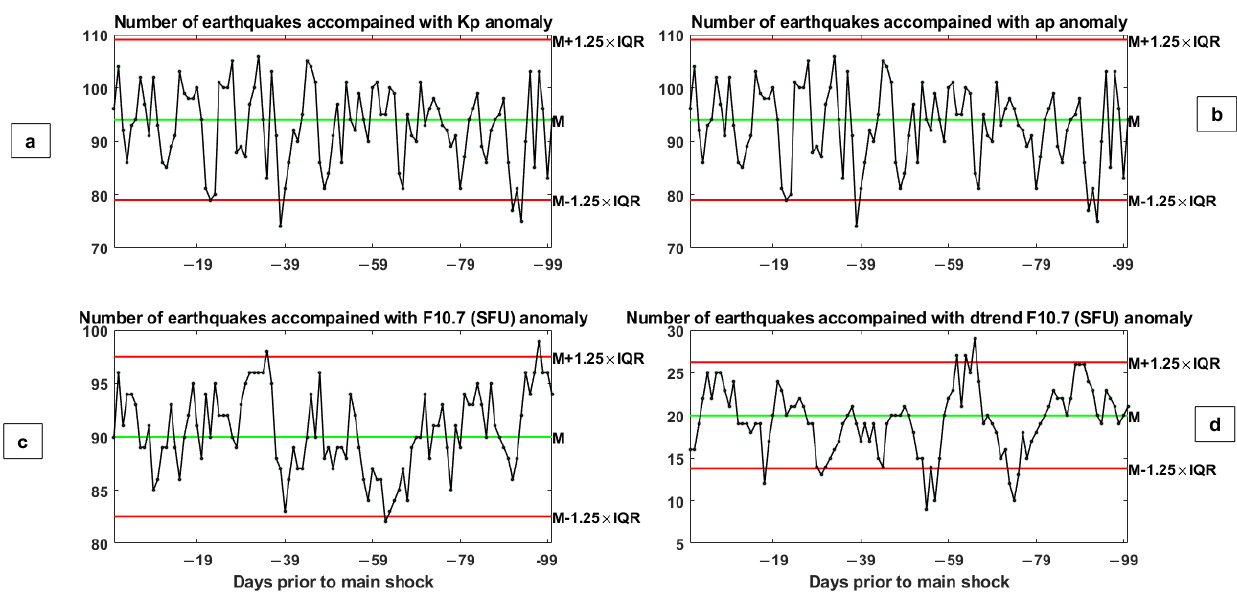
Figure 5. The number of earthquakes accompanied by anomalous changes in ( a ) Kp, ( b ) ap, ( c ) F10.7, and ( d ) dtrend F10.7 indices during the days prior to the studied